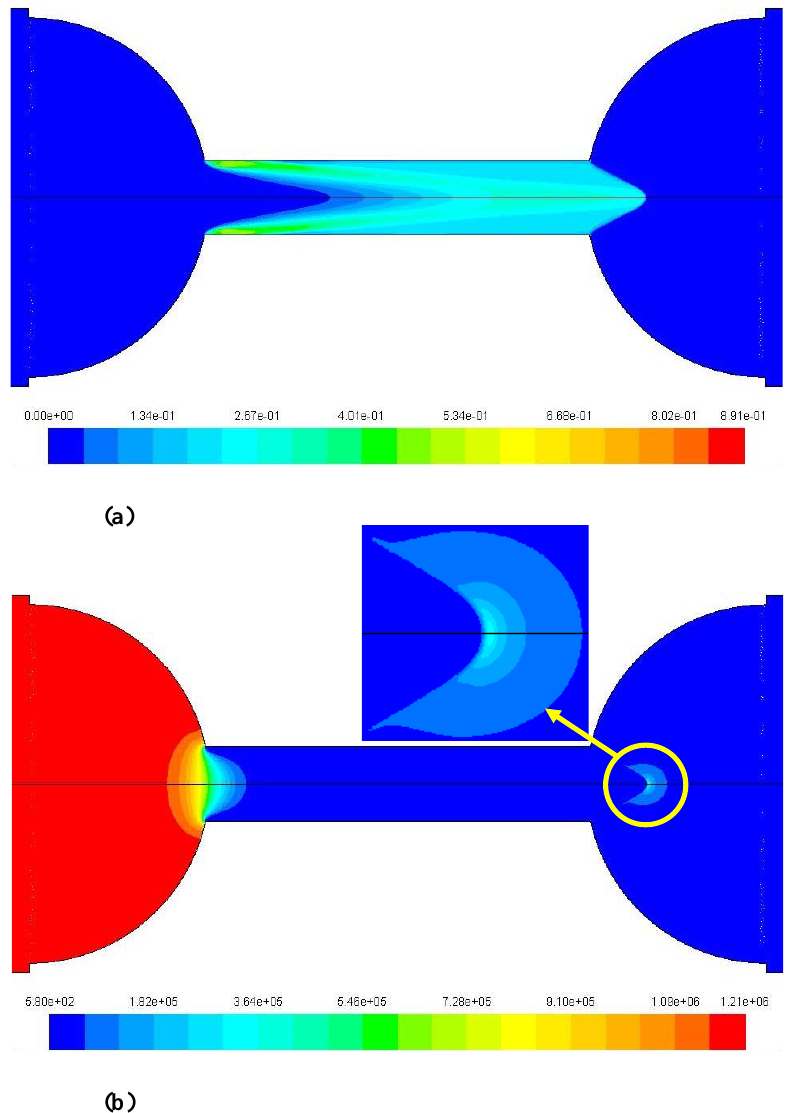
Figure 15. Predicted distribution of vapor volume fraction and absolute pressure across the nozzle; ( a ) vapor volume fraction, ( b ) pressure (Pa).